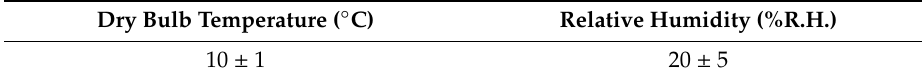
Table 3. Test environment for simulation.